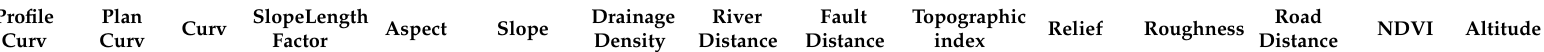
Table 4. Pearson correlation coefficient between attributes referenced by